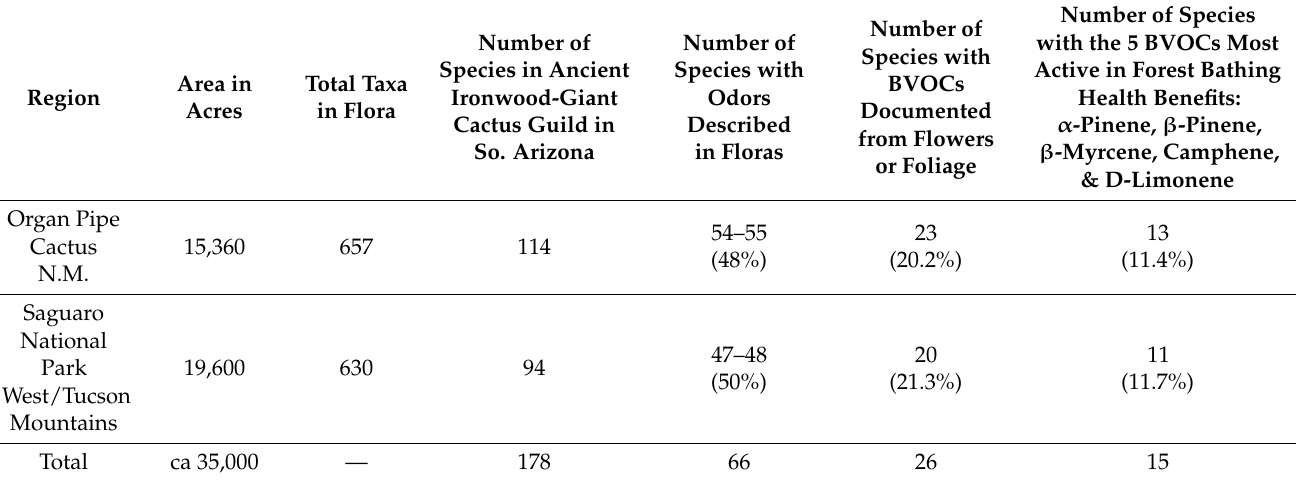
Table 1. Synopsis of Sonoran Desert flora and its percentage of plants with